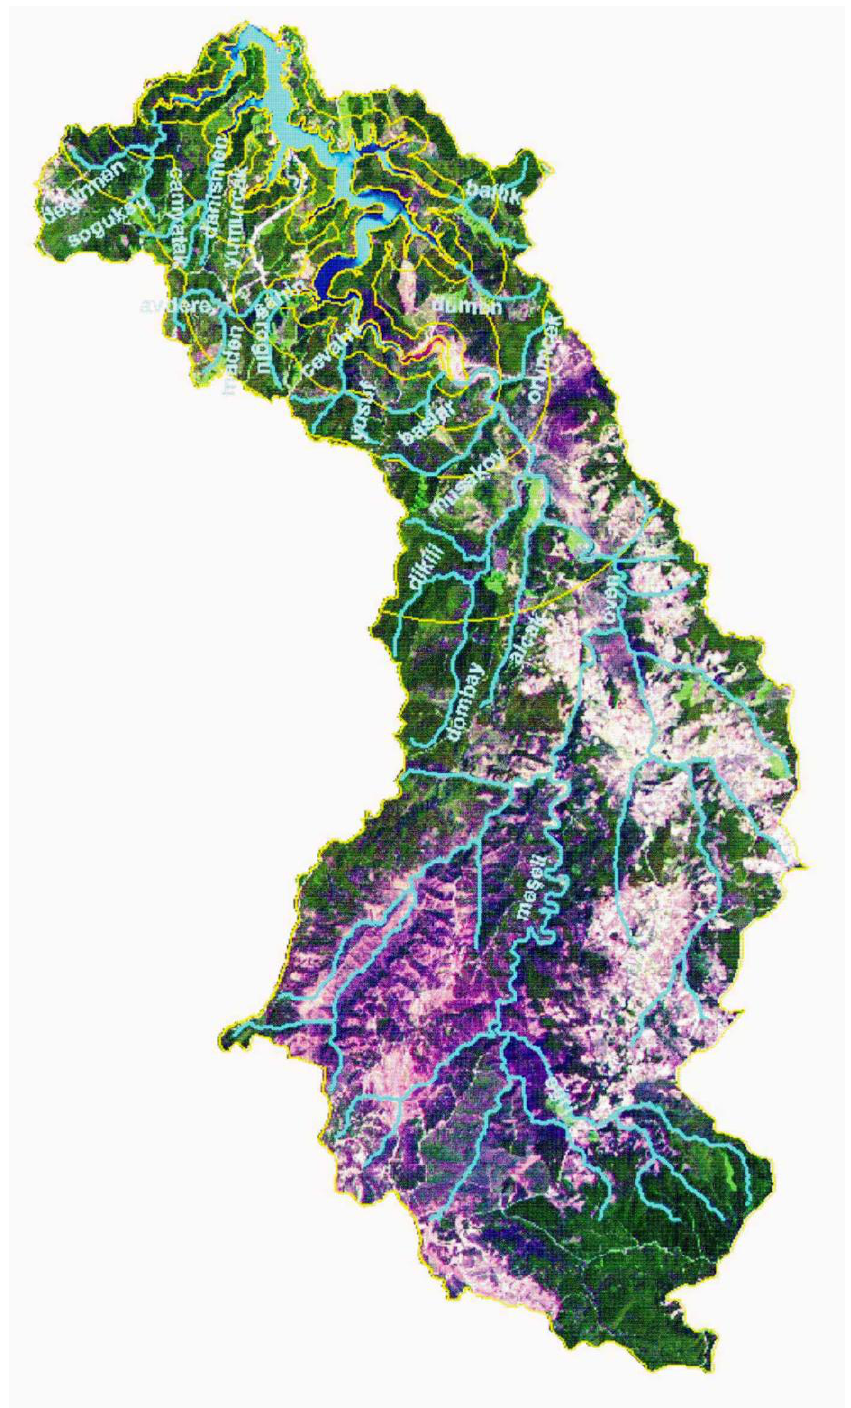
FIGURE 2. Rivers overlaid on Darlık watershed Landsat 5 TM satellite